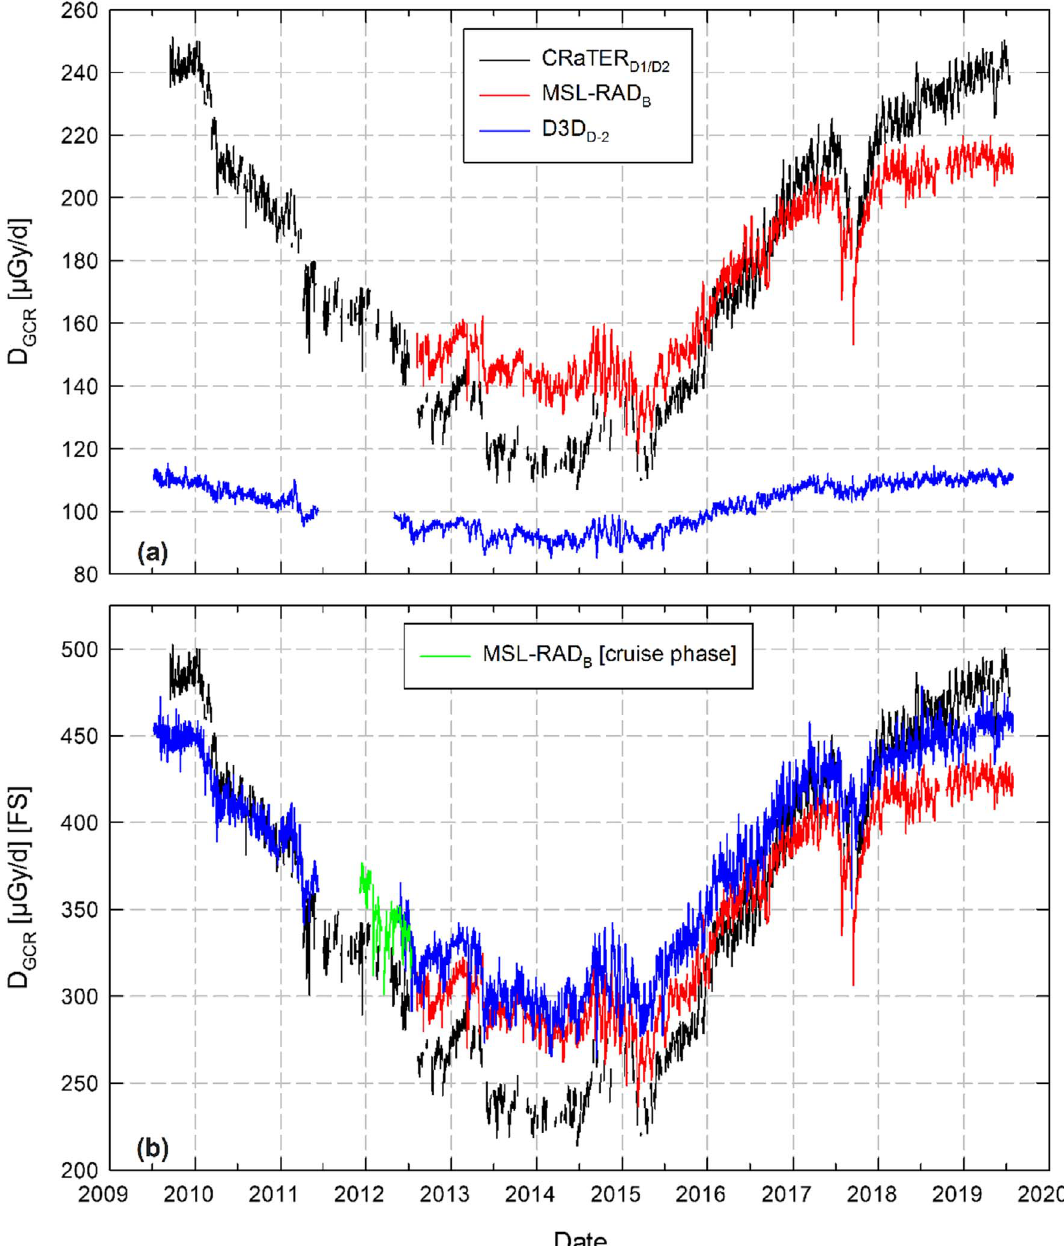
Fig. 12. (a) GCR dose rate for ISS (blue), Moon (black) and Mars (red) and (b) GCR dose for free space (FS), in addition the MSL-RAD B dose rate measured during the cruise phase to Mars (green) is provided. Note: all contributions from SPEs to the data of D3D D-2 , CRaTER D1/D2 and MSL-RAD B have been removed from (a) and